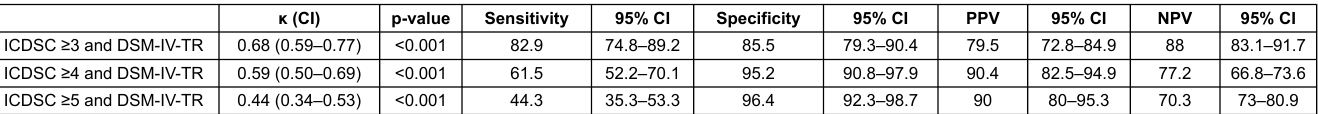
Table 4: Concurrent validities, sensitivities and specificities, as well as positive and negative predictive values (PPVs and NPVs) of ICDSC defined delirium as ≥3, ≥4, or ≥5 ver- sus the DSM-IV-TR defined diagnosis of delirium. κ